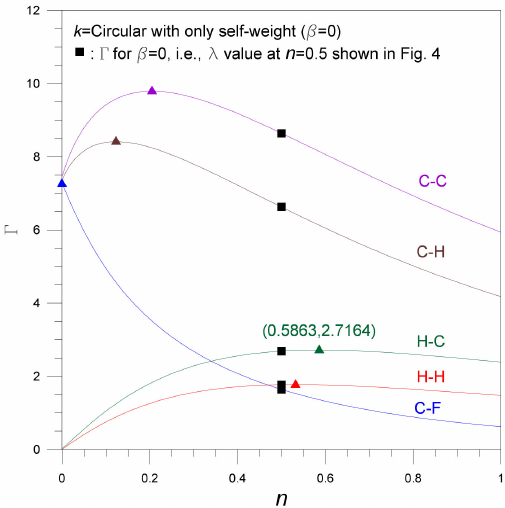
Figure 6. Curves of Γ versus n